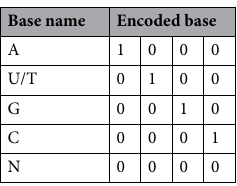
Table 2. “One-hot” encoding for the base